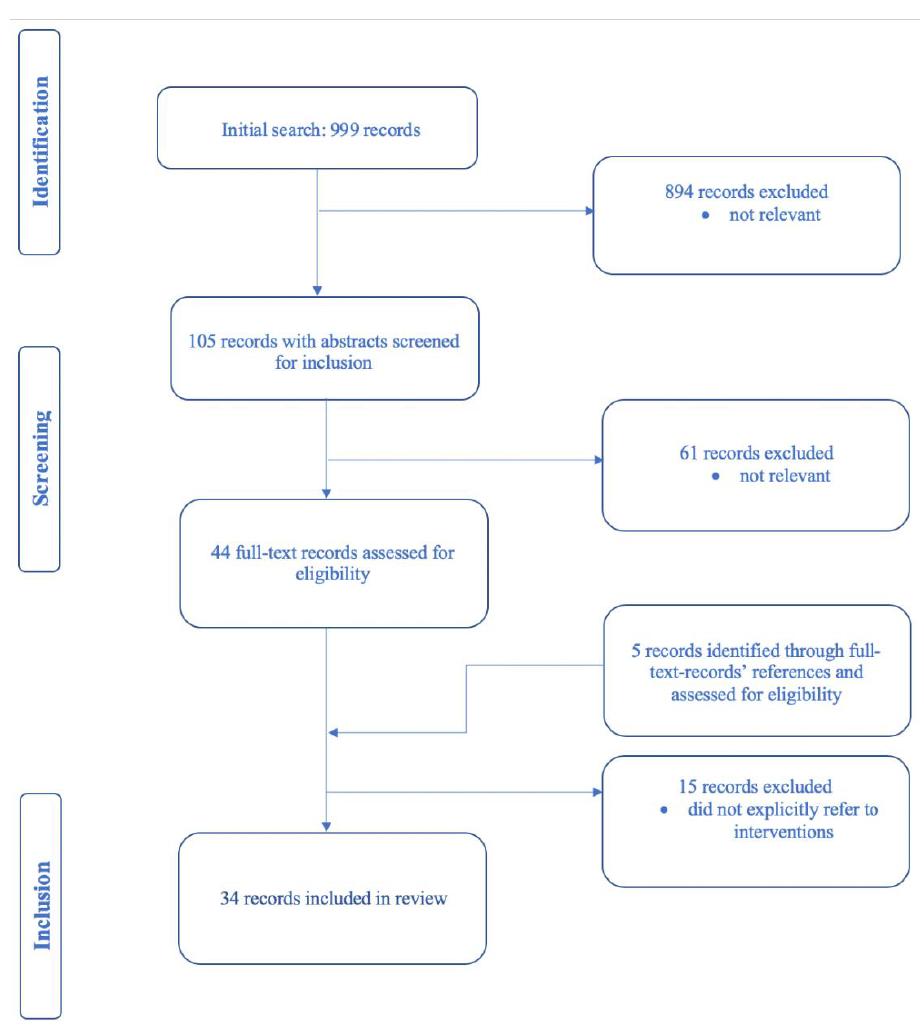
Figure 1. Records identification, screening and selection.